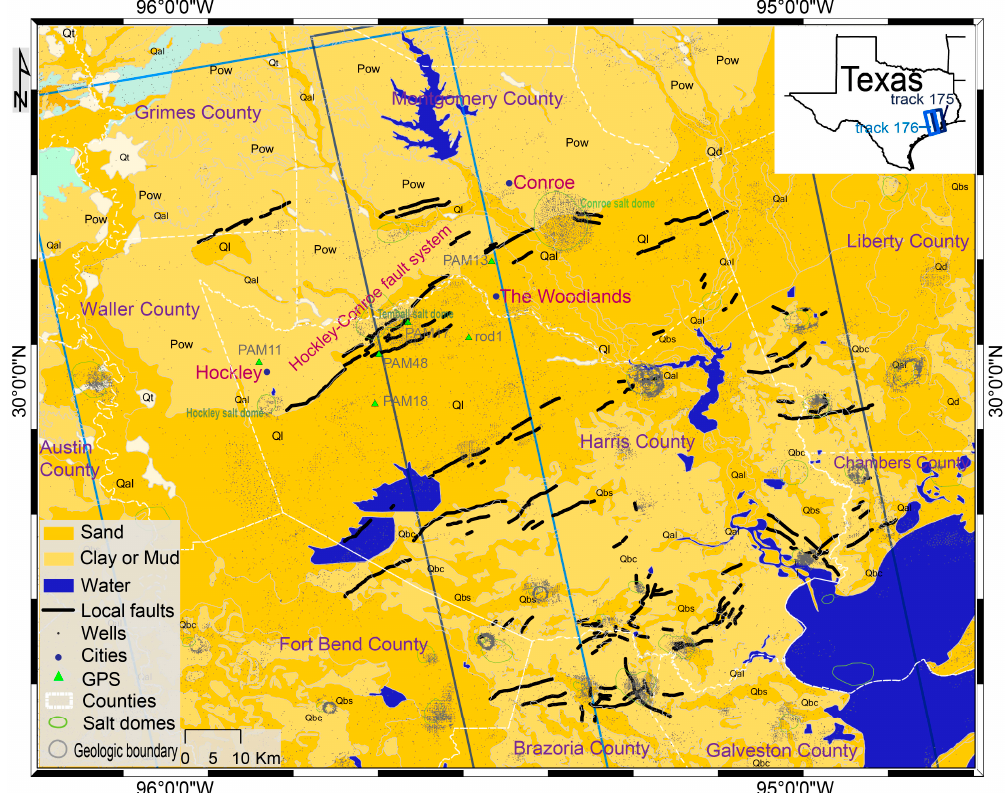
Figure 1. Geological map of GH [8], where colors represent generalized lithology, and black letters (Ql—Lissie Formation; Pow—Willis Formation; Qb—Beaumont Formation; Qbs—Beaumont Formation (sand); Qbc—Beaumont Formation (clay); Qal—Alluvium; Qt—Fluviatile terrace deposits) and grey lines show distribution of the major geologic units [1]. Faults (marked by black lines) [9,10], hydrocarbon wells (small grey dots [11]), GPS benchmarks (green triangles), salt dome positions (green polygons) and county boundaries (white dashed lines, county names are labeled by purple letters) are superimposed. The blue and black rectangles show coverage of two neighboring Advanced Land Observing (ALOS) data. The Texas State district is shown as an inset map on the upper-right corner.